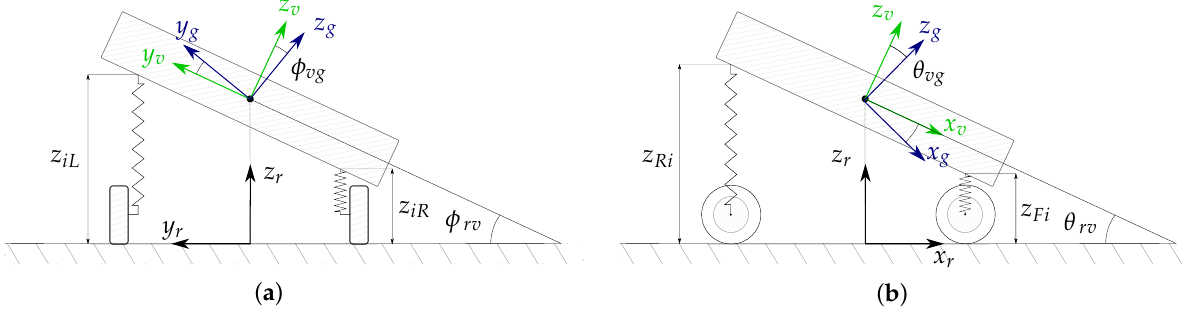
Figure 4. Vehicle-to-road pose [3]. ( a ) shows the roll model, where i ∈ [ F,R ] ; ( b ) depicts the pitch model where i ∈ [ L,R ]